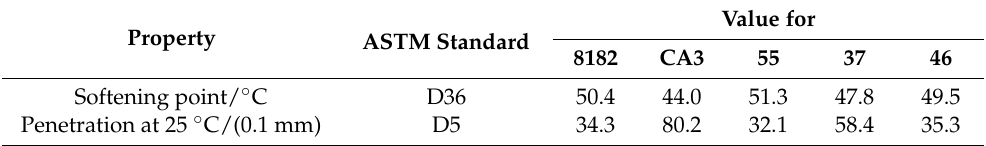
Table 5. Test results of rejuvenated asphalt.